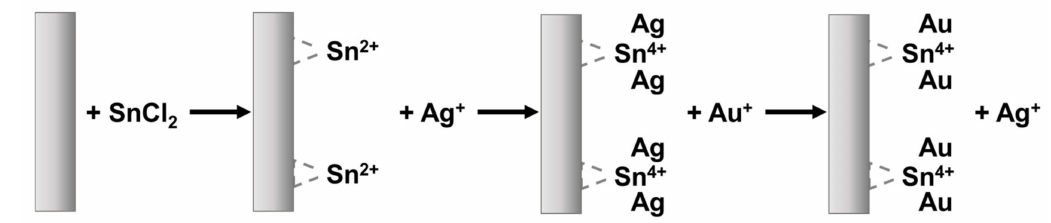
Figure 8. Illustration of the electroless deposition